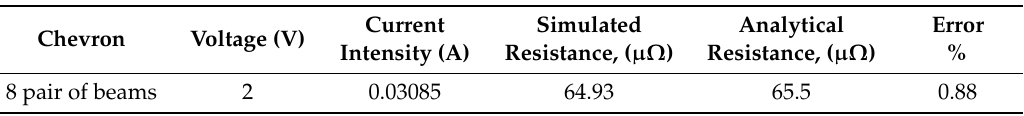
Table 5. Comparison of resistance